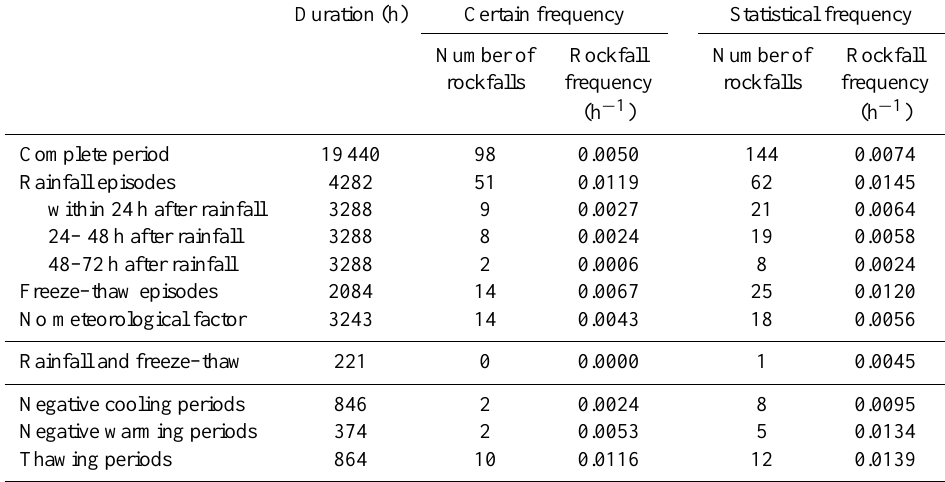
Table 5. “Certain” and “statistical” rockfall frequencies based on the DB2 for different meteorological